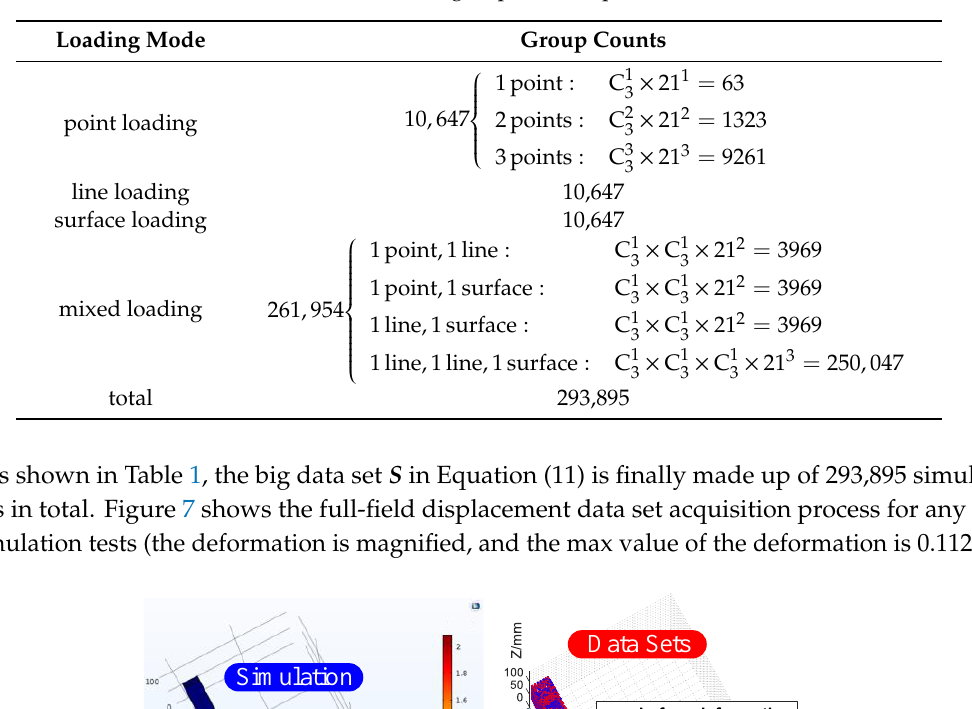
Table 1. Simulation groups of each positioner.